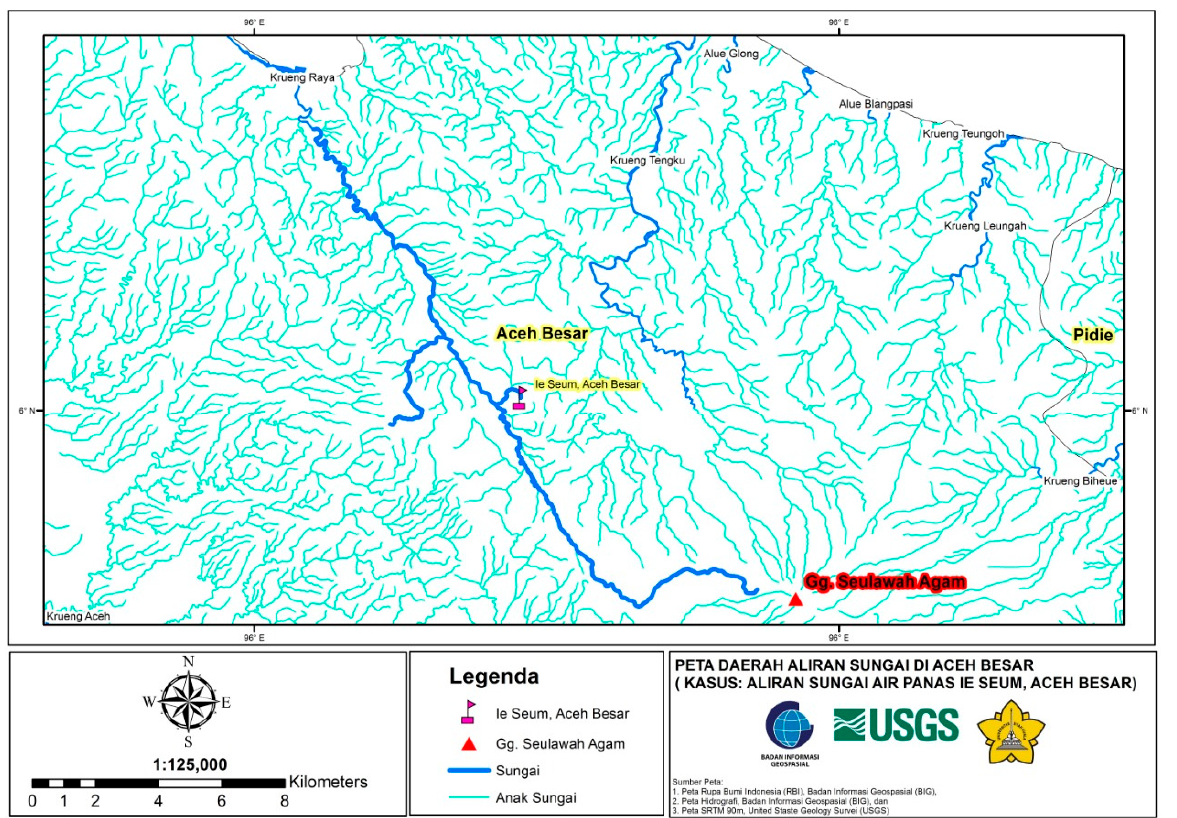
Figure 1. Sampling points based on Google Earth satellite image.